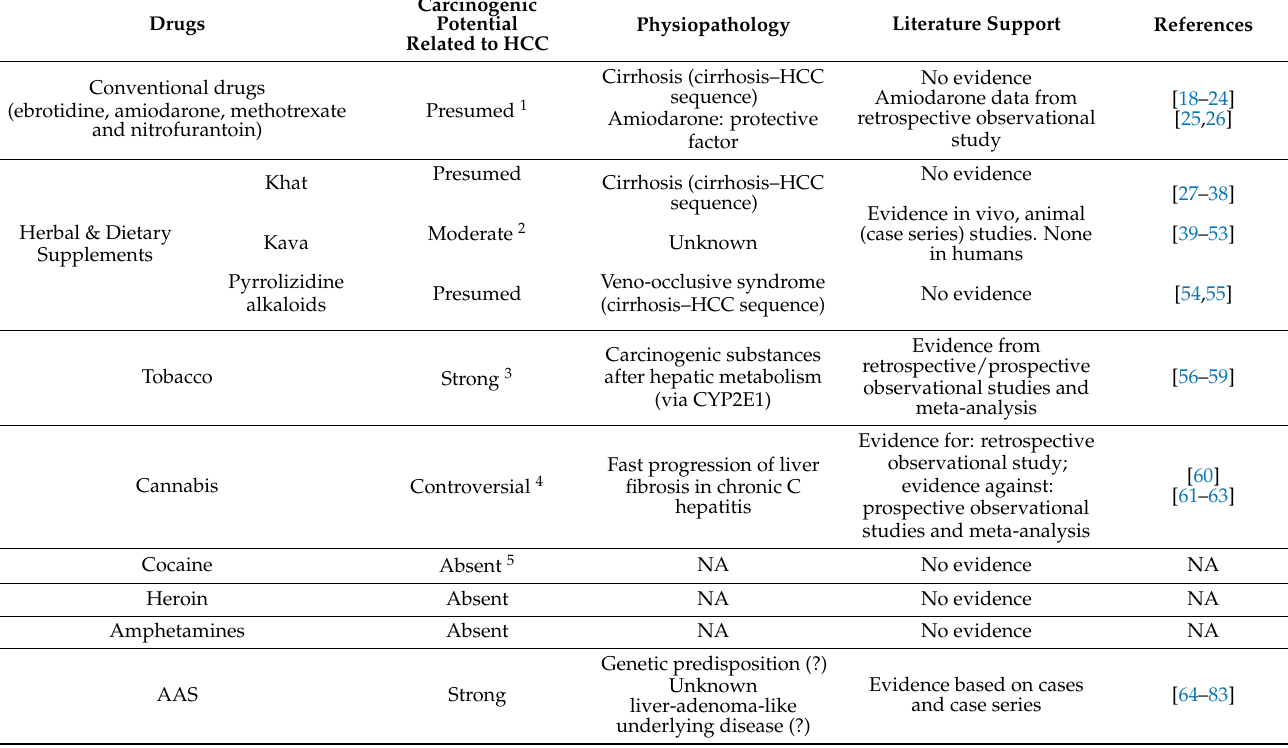
Table 1. Overview of the impact of recreational drugs on the risk of hepatocellular carcinoma.